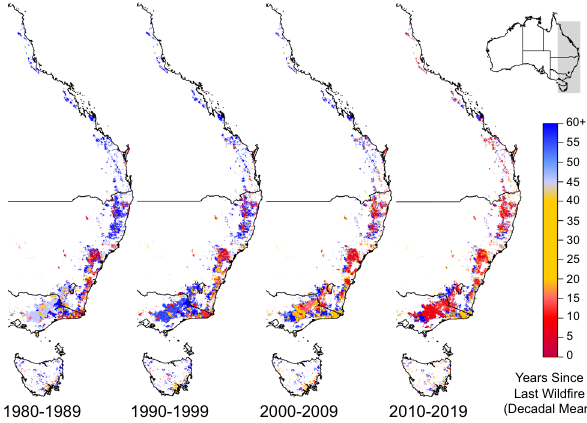
Fig. 4 Number of years since the last wild fi re (decadal mean) for forested areas. Analysis based on forested areas that have burned at least once since fi re records began in the 1930s for most states. Spatial resolution is 250-metres. Data: State and Territory fi re histories.